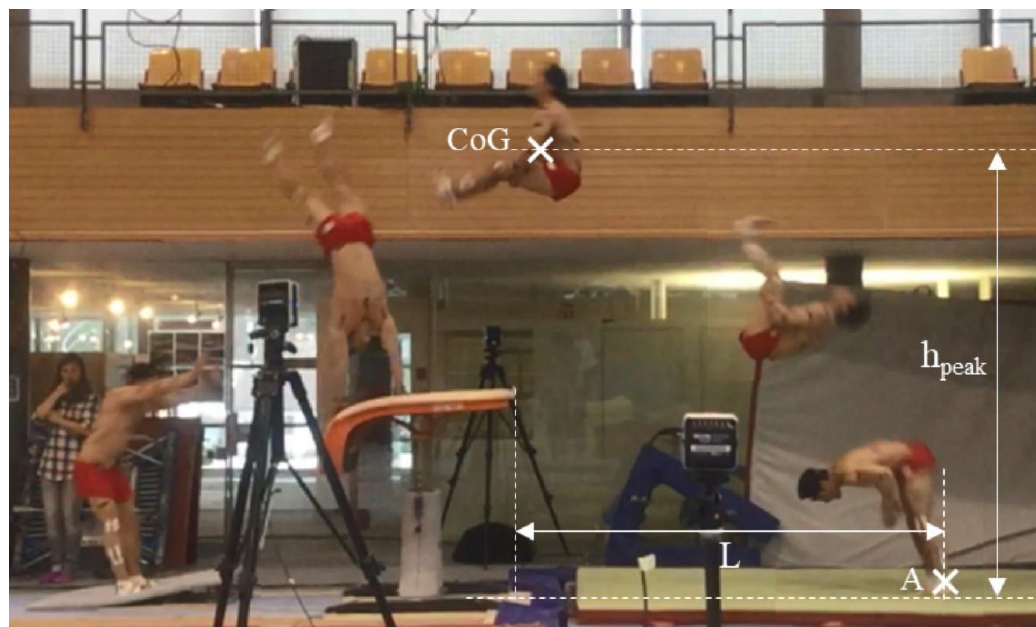
Figure 2. 2D measurements: determination of peak height (h peak ) and length of flight (L) for a “Yeo” Vault (CoG: position of center of gravity at the highest point of the second flight phase; A: position of the ankle at first foot contact).